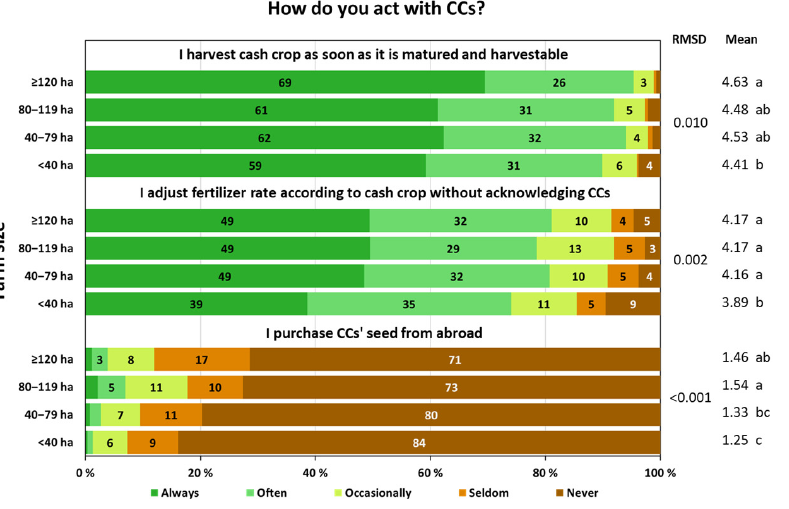
Figure 8. The distribution of farmers’ answers (N = 1130) depending on the farm size (RMSD, row mean scores difference; CCs, cover crops).